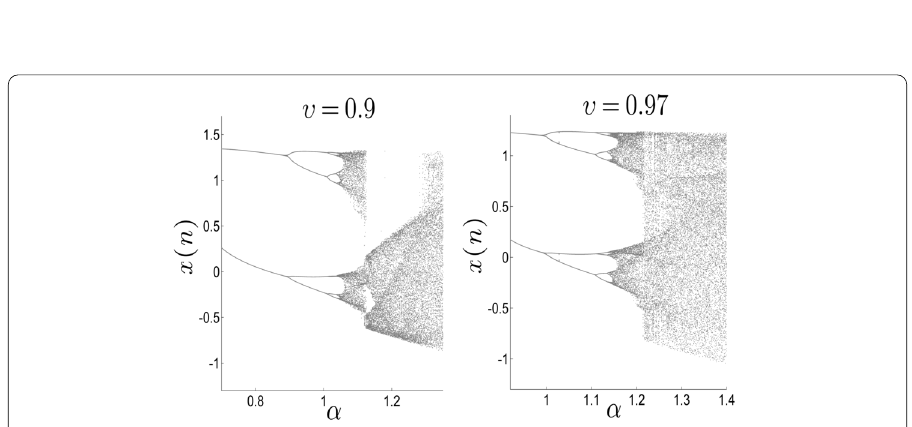
Figure 3 Phase space of the fractional-order Stefanski map for υ = 0.969